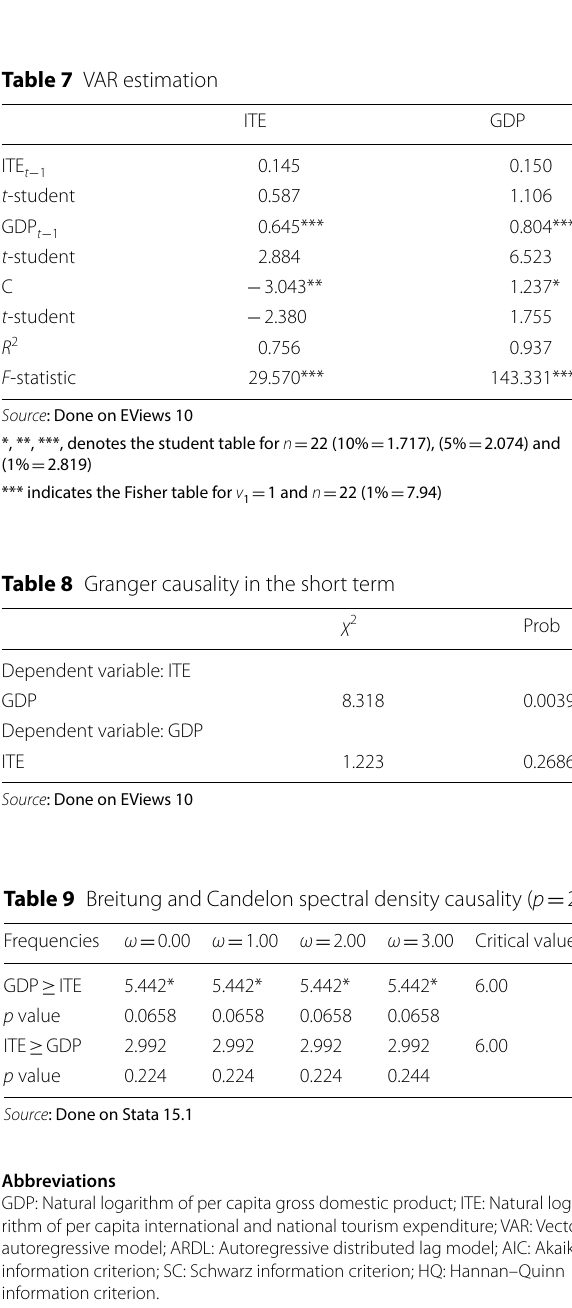
Source : Done on Stata